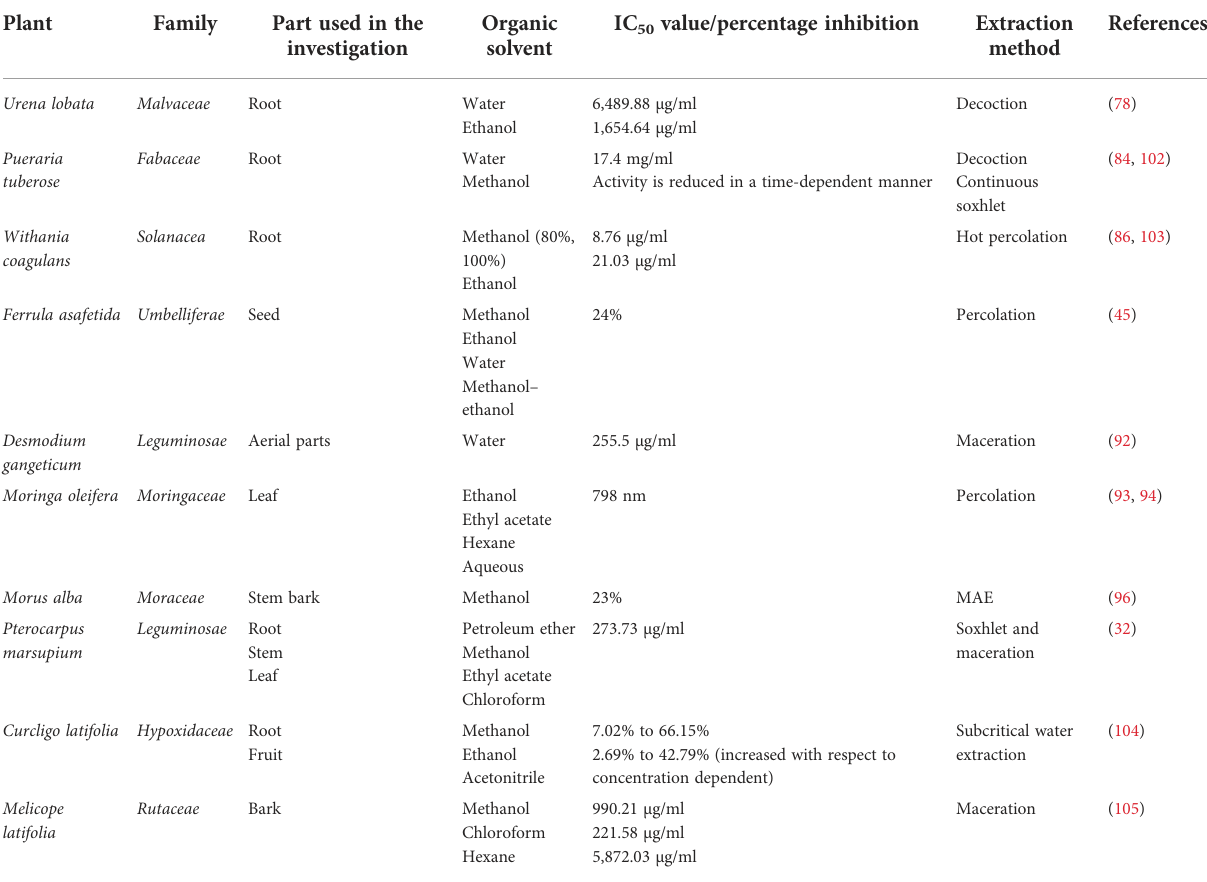
TABLE 2 Inhibitory role of different tropical plant extracts against dipeptidyl peptidase-IV enzyme.